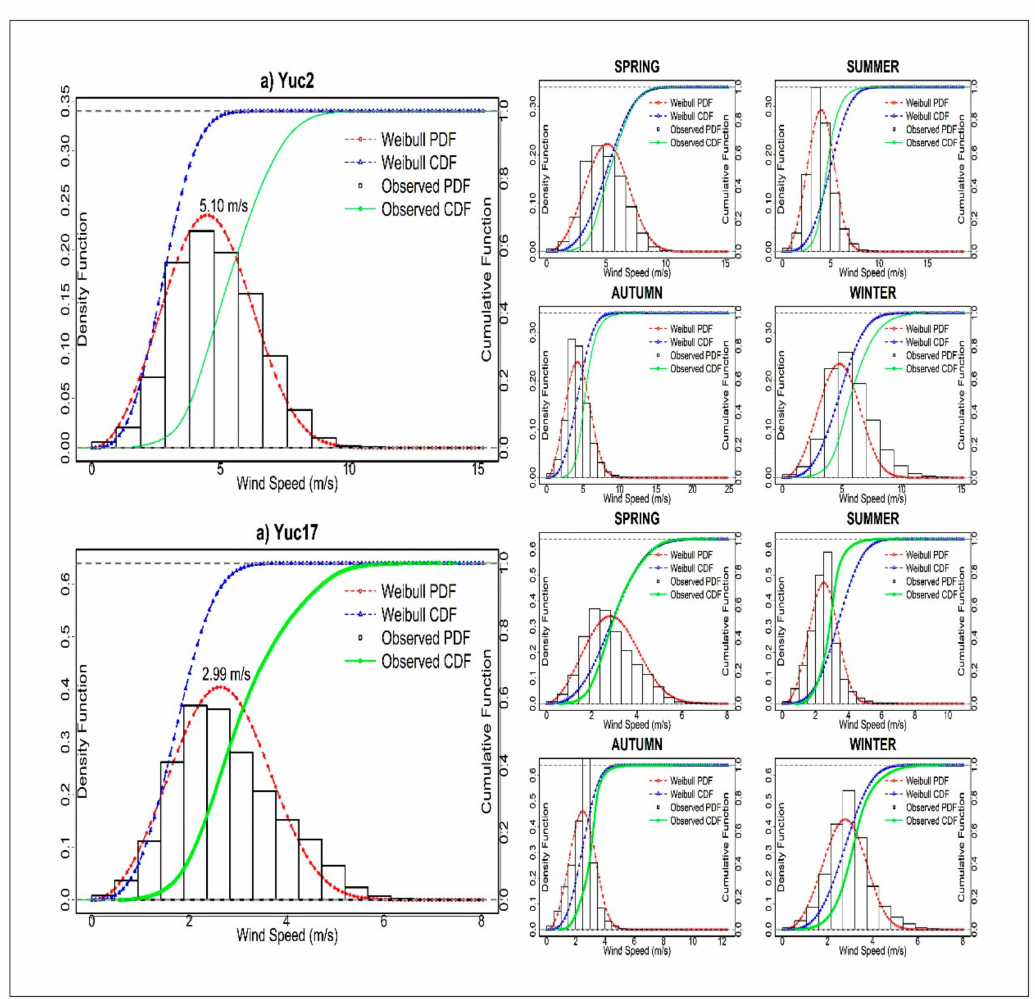
Figure 8. Annual and seasonal Weibull distributions for the state of